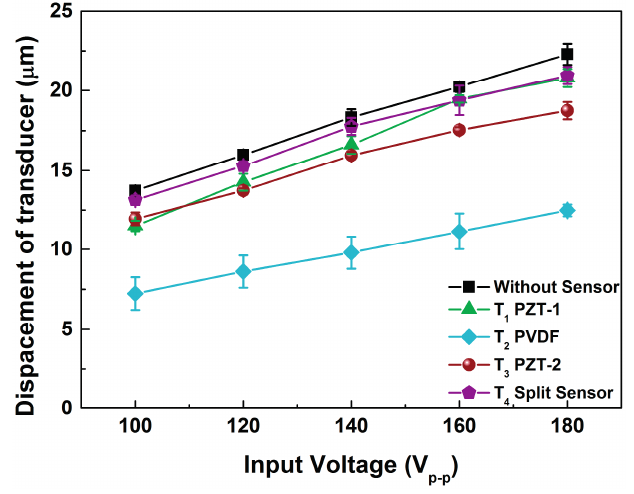
Figure 9. Longitudinal displacements of various sensor